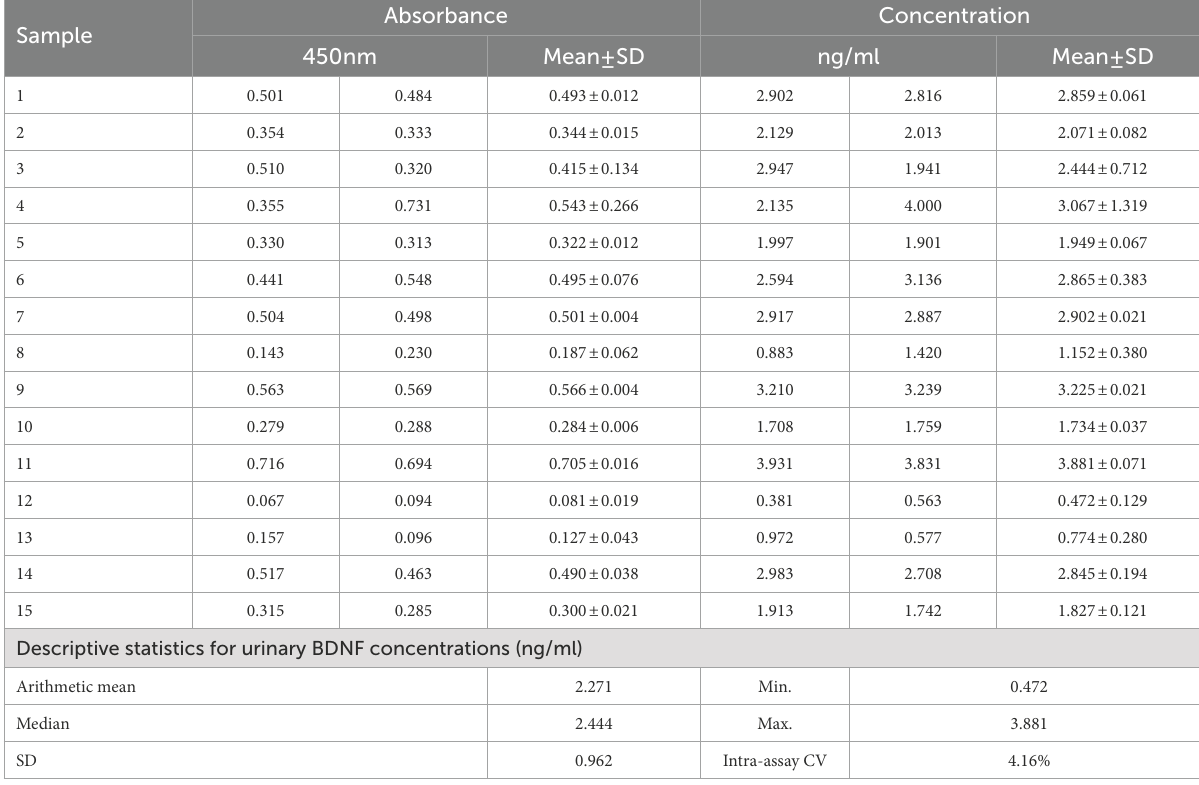
TABLE 2 Absorbance and BDNF concentrations in duplicate human urine samples.